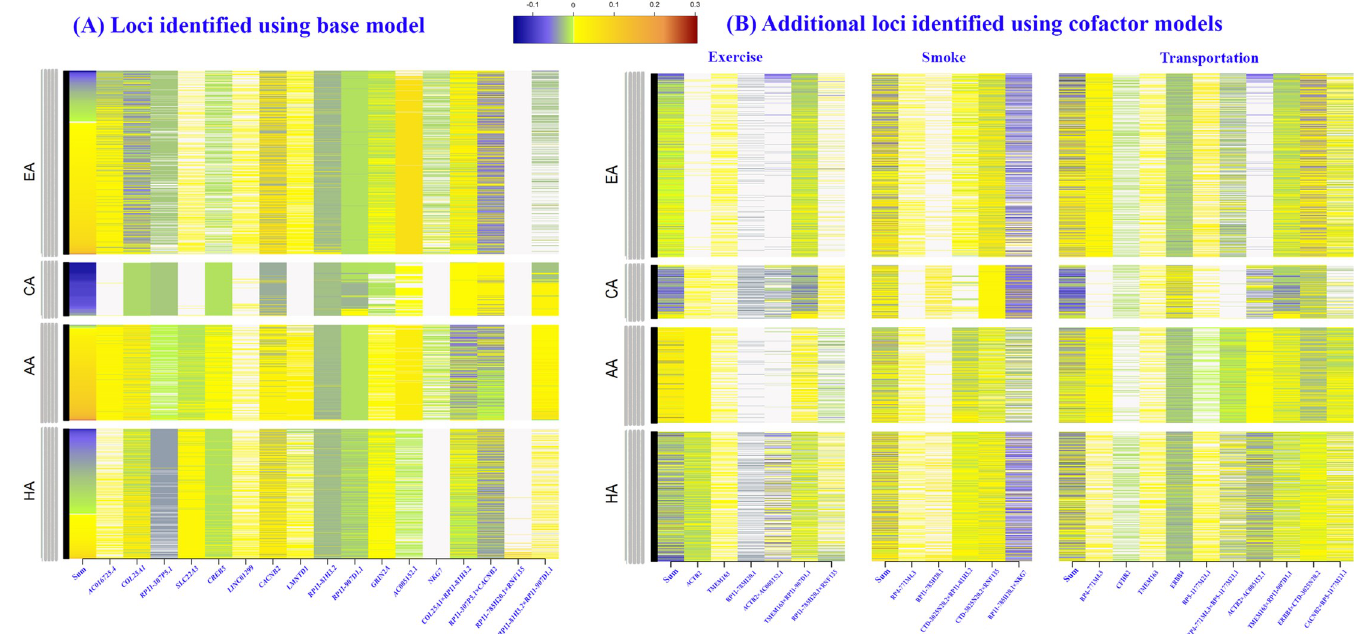
Fig 2. Genetic effects matrix (G + GE) image plot of BSA loci. (A) Identified loci using the base model; and (B) suppressed loci by cofactors. Vertical axis for the size of genetic effects including four ethnic groups: HA = Hispanic-American, AA = African-American, CA = Chinese-American, EA = European-American; horizontal axis for the individual and epistasis loci; different color present different genetic effects according to a color scale, where gray color = no significant